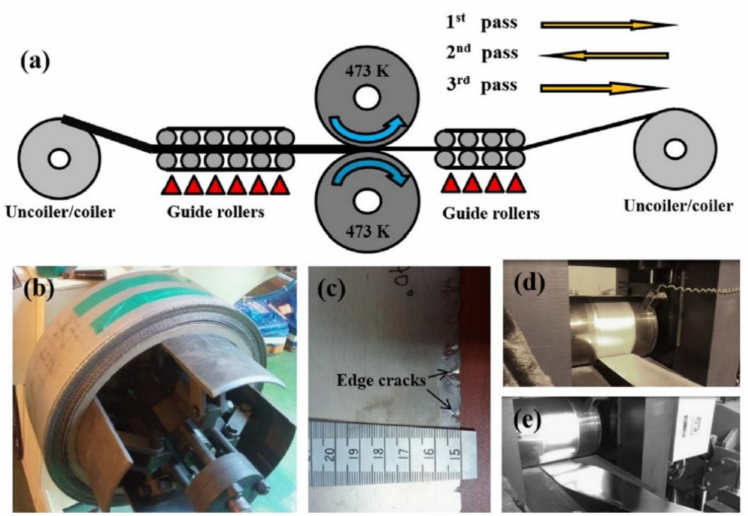
Figure 35. ( a ) TEM micrograph of AZ31 sheet obtained after high-ratio differential speed rolling ( S R = 2) at 150 ◦ C followed by immediate water quenching. ( b ) Al–Mn and ( c ) β -Mg 17 Al 12 particles in the matrix, reproduced from [116], with permission from Elsevier, 2011.